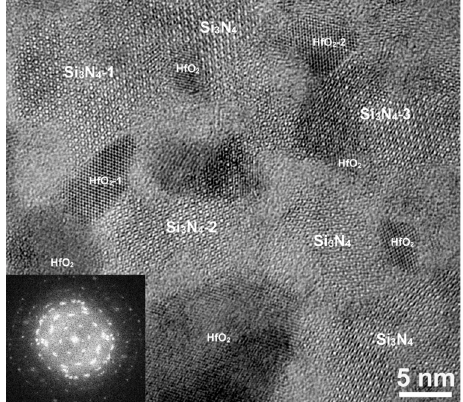
Figure 6. Plan-view HRTEM image (with inset FFT) of local structure between Si 3 N 4 and HfO 2 nano grains in the transition layer in the Hf 6 B 10 Si 31 C 2 N 50 film.